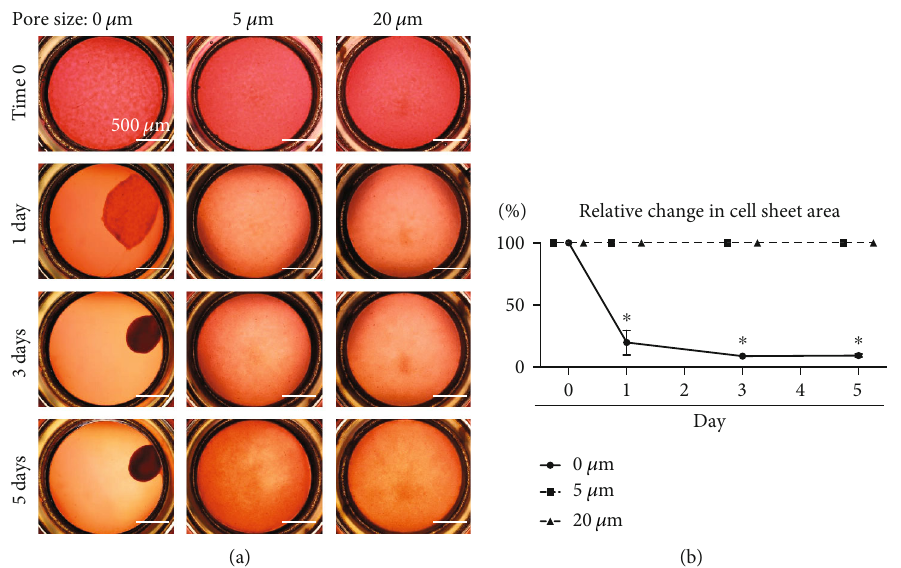
Figure 4: Early phase of cartilage formation by synovial MSCs on PLA fi lms. (a) Time lapse pictures. MSCs ( 5 : 0 × 10 5 in 500 μ L medium) were plated, cultured in chondrogenic induction medium, and then continuously observed. (b) Relative change in cell sheet area. Means and standard deviations are shown ( n = 3 ). ∗ P < 0 : 05 . P values were determined by the two-way ANOVA with Tukey ’ s multiple comparisons test.